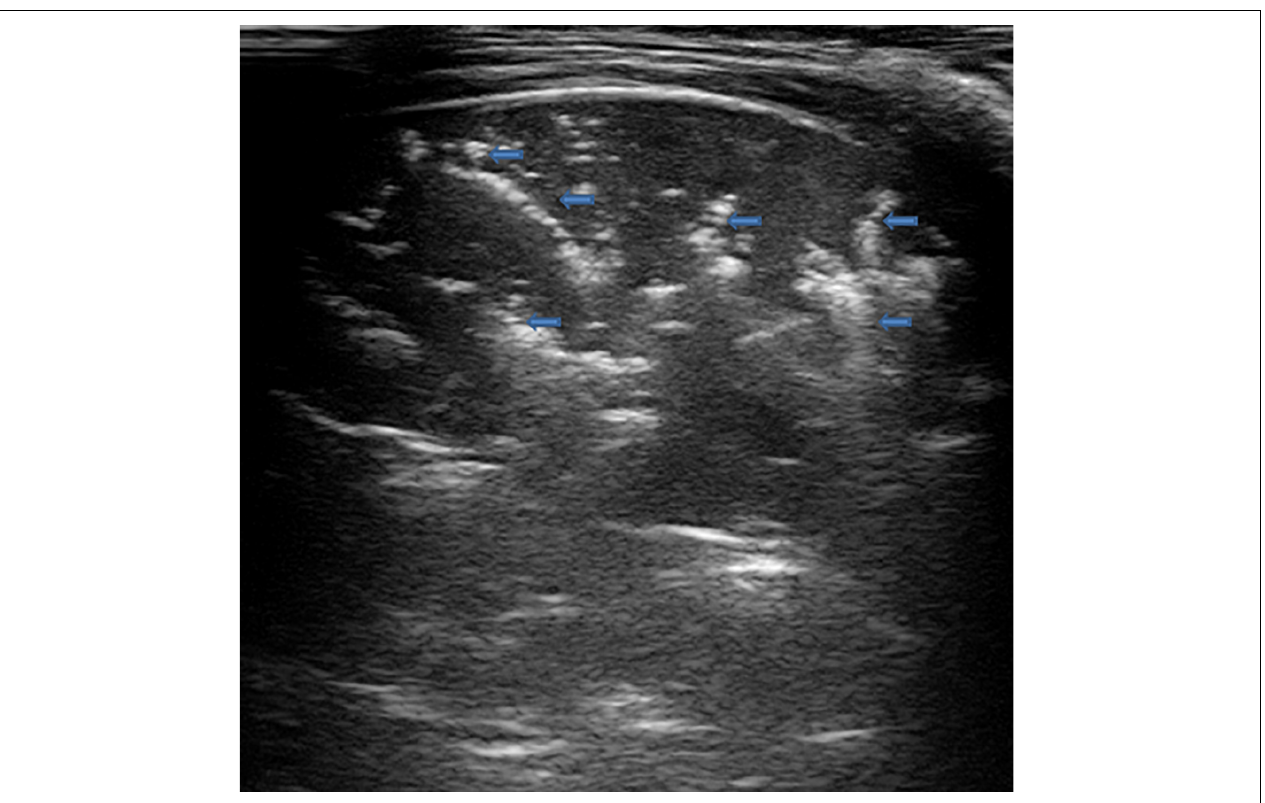
FIGURE 6 | Grayscale lung ultrasound examination (transverse scan between intercostal fields; linear probe with 12 MHz frequency) of a 5-year-old boy with bacterial pneumonia lobar, shows subpleural consolidation of an inflammatory/infectious nature with numerous elements of surface dynamic arborized bronchograms ( arrows ) – ( Electronic Supplementary Video 3 ) and deep fluid